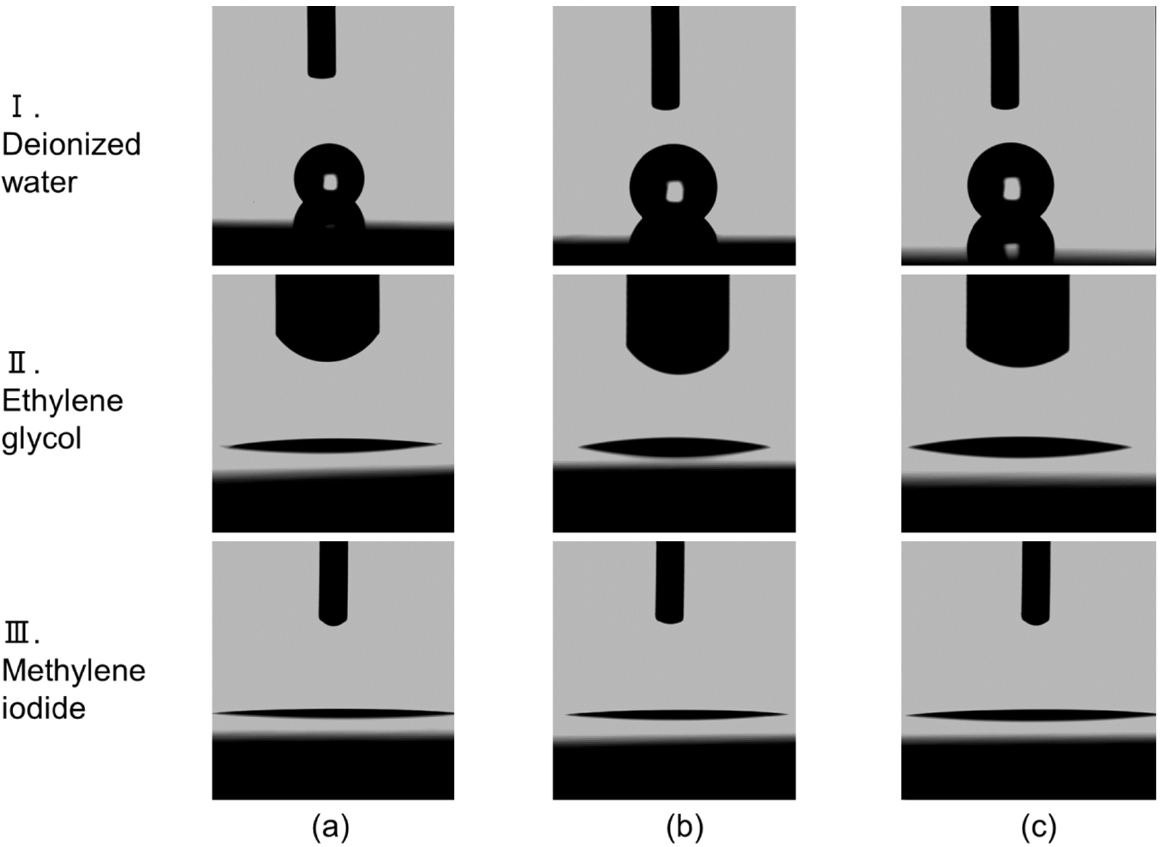
Figure 7. Optical photographs of droplet impressions taken during contact angle measurements on CNWs surfaces grown with various oxygen flow rates . ( a ) Normal CNWs, ( b ) 5-sccm-O 2 –, and ( c ) 10-sccm-O 2 – high-quality CNWs. Row (I) deionized water, (II) ethylene glycol, and (III) methylene iodide.